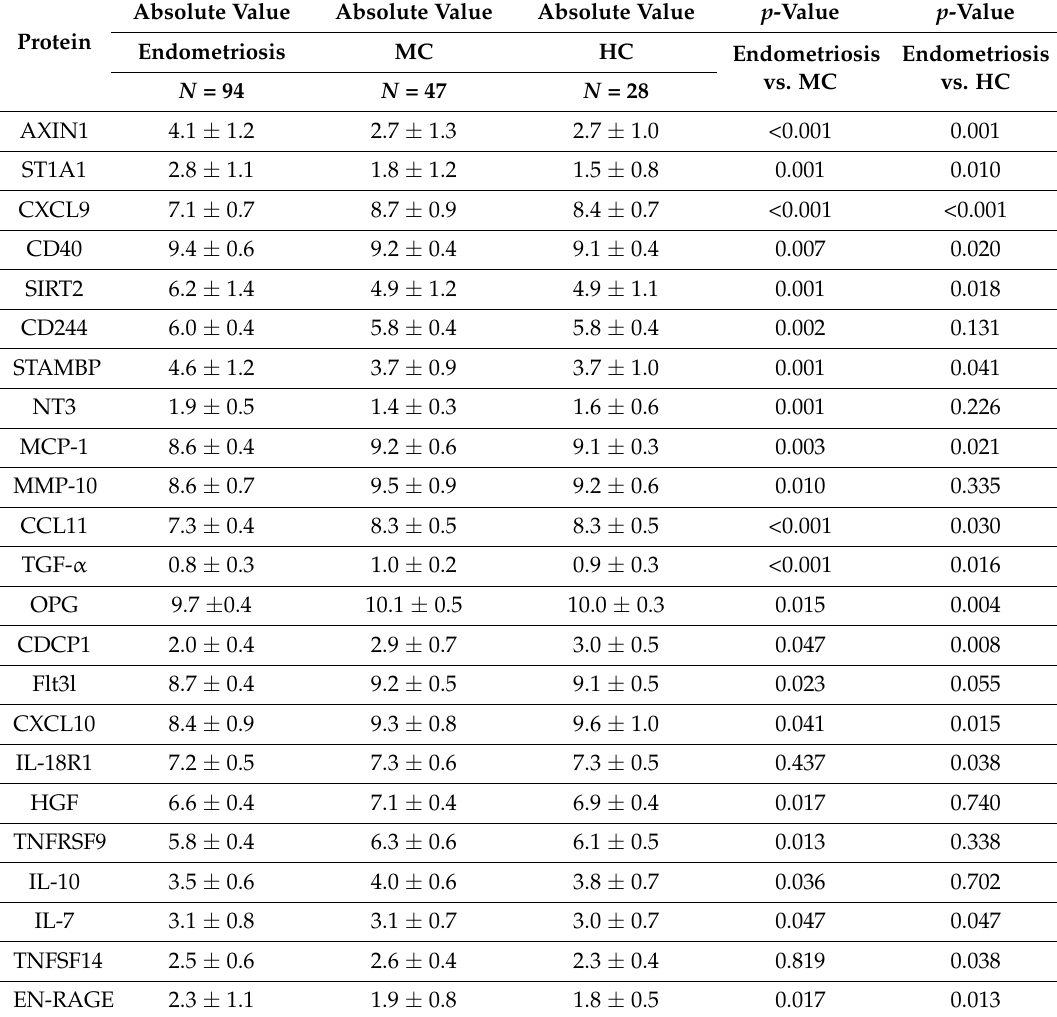
Table 2. Protein expression in endometriosis and